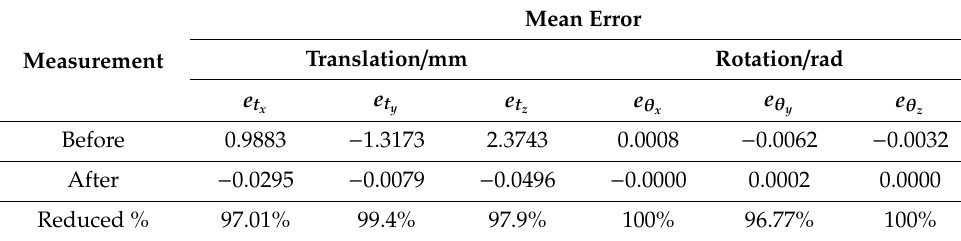
Table 3. Mean error of the measurement system position-accuracy.